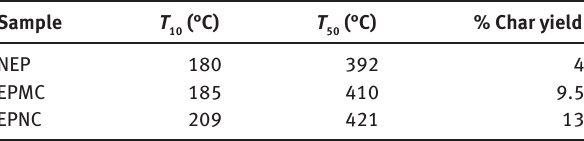
Table 2: Thermal properties of NE, EPMC, and